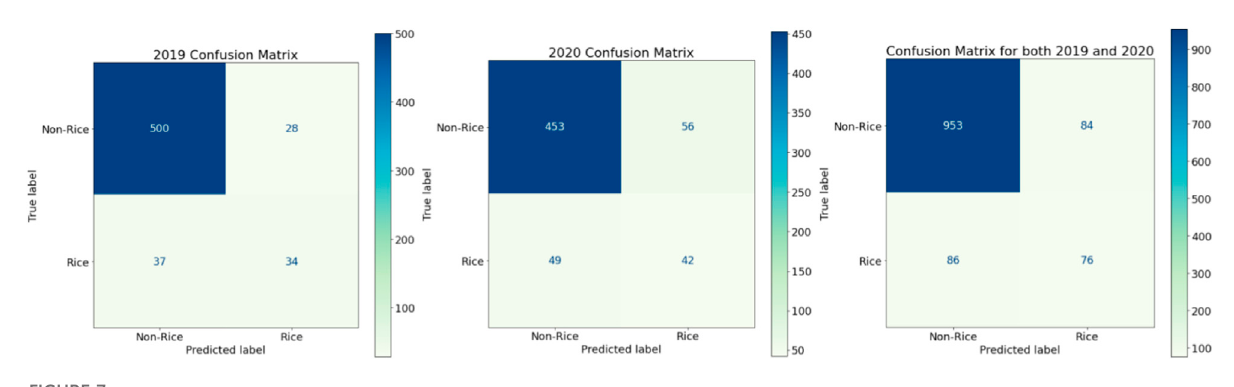
FIGURE 7 Independent validation classi fi cation results.